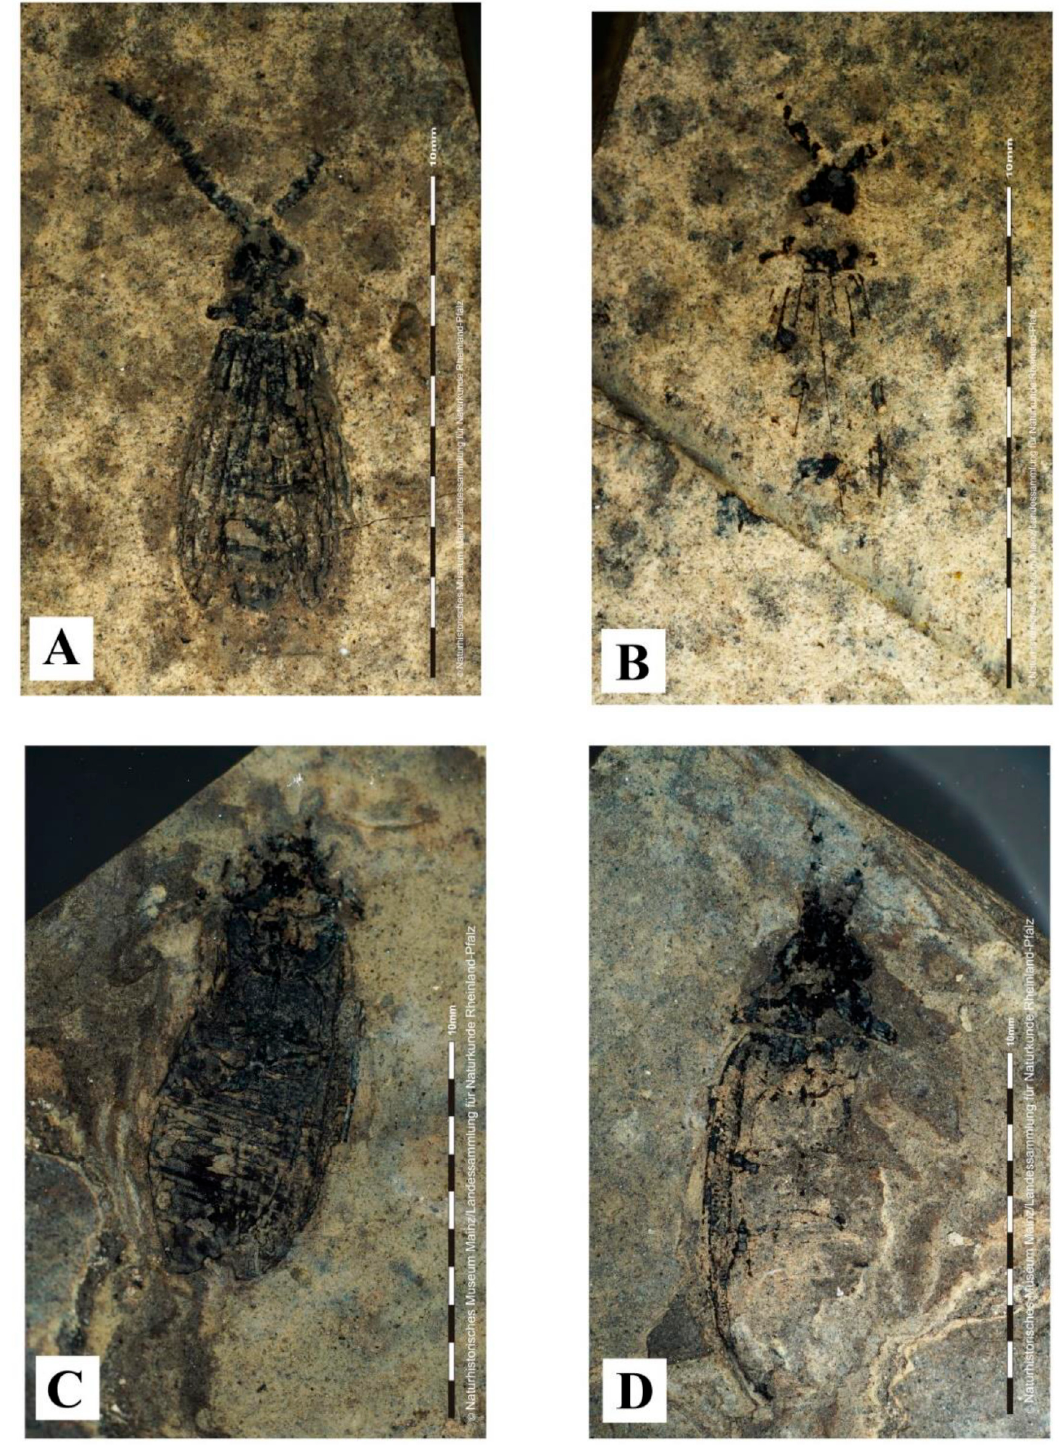
Figure 20. Cupedinae (Cupedidae). Species of Cupes from Eckfeld (Palaeogene, Eocene, Lutetian; Eifel, Eckfeld Maar). A – B — Cupes golovatchi sp. nov. , holotype, PE 200001146 a (LNNR), part (A) and PE 200001146-b (LNNR), counterpart (B). C – D — Cupes legalovi sp. nov. , holotype, PE 1992000522-a (LNNR), part and PE 1992000522-b (LNNR), counterpart. Scale for each picture provided. Original.